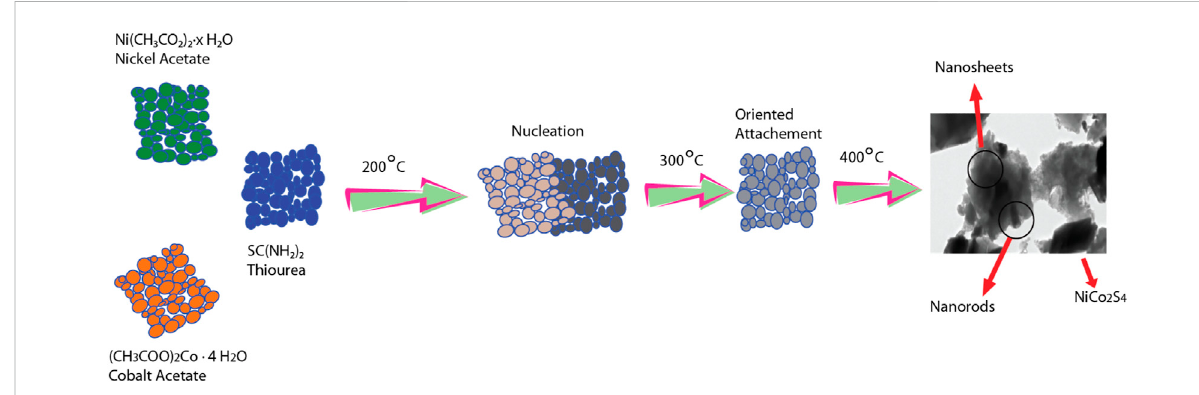
FIGURE 1 Schematic representation of steps involved e.g., nucleation, growth, and oriented attachment.